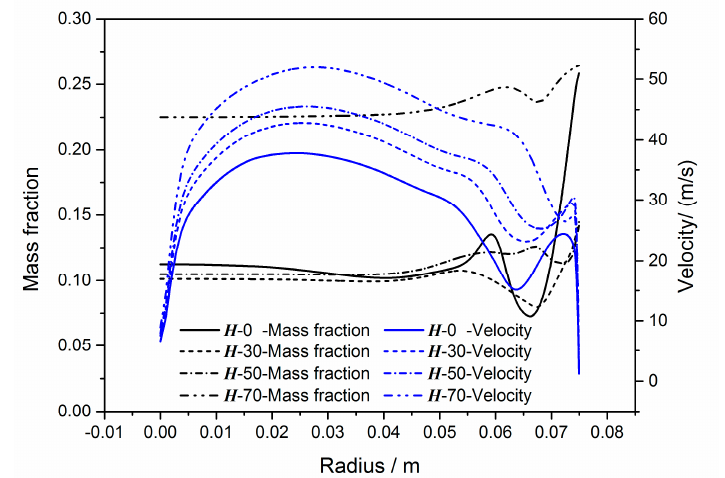
Energies 2016 , 9 , 1072